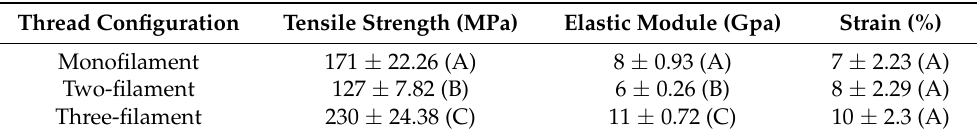
Figure 4. Representative strain-stress curves ( n = 10) of the mono- and multifilament chitosan threads. Table 2. Mechanical properties of the mono- and multifilament chitosan threads obtained by uniaxial tensile testes (mean ± standard